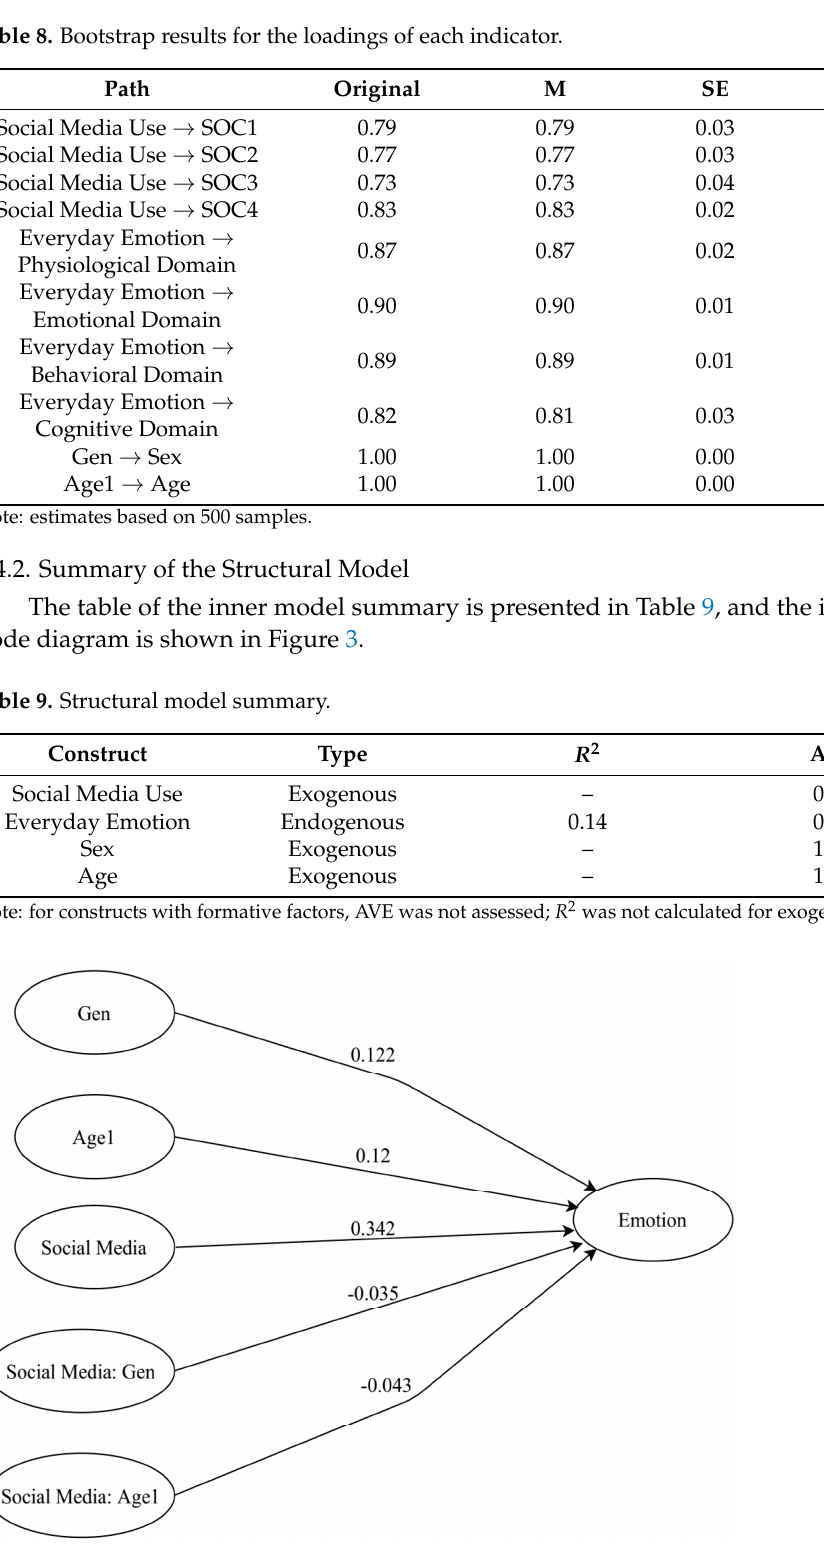
Figure 3. Inner node diagram for the SMU-EE model. R 2 -values. Table 9 shows the R 2 -values for the endogenous latent variable; emotion was 0.14, which is considered a weak explanatory power [62].